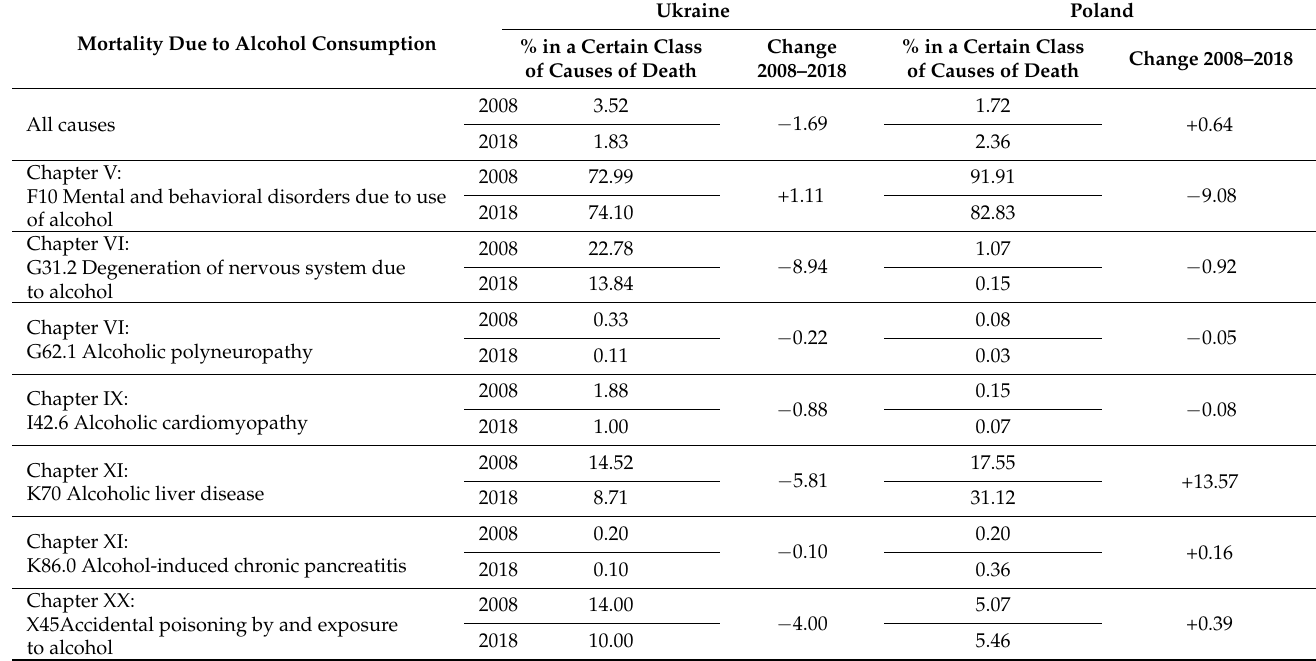
Table 2. Change in the proportion of mortality caused by alcohol consumption in certain classes of causes of